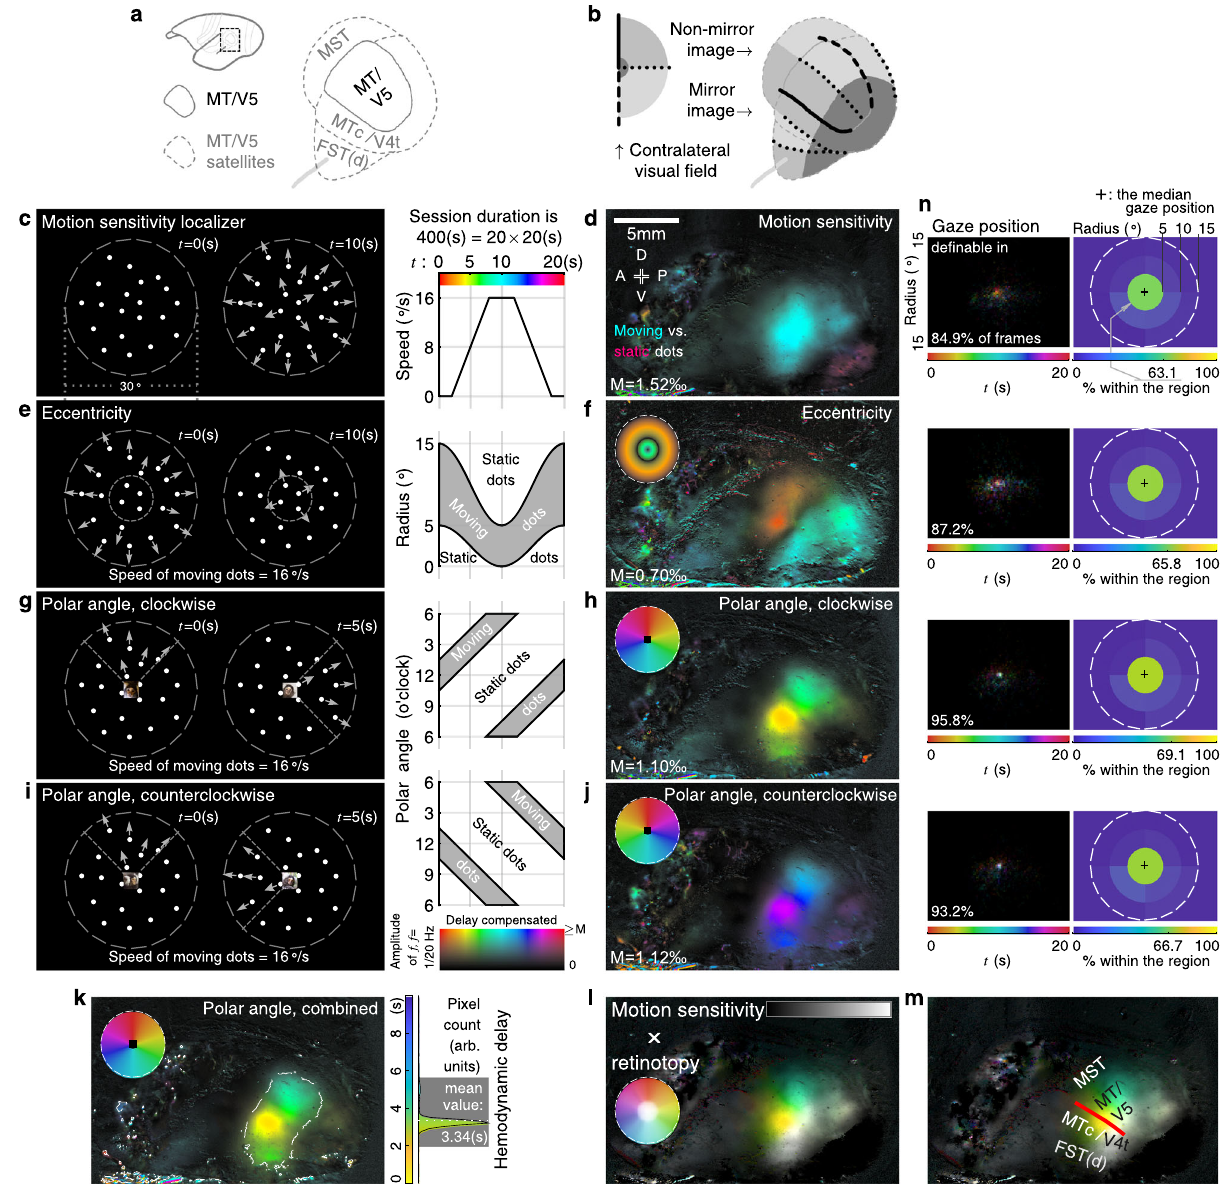
Fig. 5 Through-skull retinotopy and motion-sensitivity mapping in the MT/V5 complex. a A sketch of marmoset MT/V5 complex 10,33 . MST: medial superior temporal area, MTc/V4t: MT crescent/transitional V4, FST(d): fundal area of the STS (dorsal). b The retinotopic organization of marmoset MT/ V5 complex, as in Rosa and Elston 1998 33 . c , e , g , i Stimuli for mapping motion sensitivity ( c ), retinotopic eccentricity ( e ), and polar angle tuning with clockwise ( g ) and counterclockwise ( i ) sequences. d , f , h , j Resulted maps in subject M126D (the same subject as in Figs. 2, 3f, 6, 7. See also Supplementary Fig. 6 for all tested subjects). A: anterior; P: posterior; D: dorsal; V: ventral. k Combined polar angle map with a hemodynamic delay histogram. The top 10% of most responsive pixels are outlined (dashed curves) and counted in the histogram. Rectangular gray shade: the acceptable delay range. l The summary map by combining the retinotopic and motion-sensitivity maps. These maps are encoded into separate channels in the HSV color space. The polar angle tuning ( k ) is encoded in the hue (color) channel, whereas the eccentricity ( f ) is encoded in the saturation (chroma) channel. The color wheel incorporates these retinotopic features: a pixel sensitive to the center (< 5° radius) would appear in white, whereas a pixel sensitive to the periphery would appear in a vivid color according to its polar angle tuning. The motion sensitivity ( d ) is encoded in the value (intensity) channel. The more motion sensitivity a pixel exhibits, the brighter it appears. m A putative assignment of area labels. The red line: the polar angle tuning reversal. n Eye- tracking results of these sessions. The calibrated and de fi nable gaze position of each frame is color-coded for its cycle timestamp and overlaid in a 2D visual fi eld histogram (left panels). A white spot in the histogram implies the position was not preferred by any speci fi c time point in the cycle. For each session, the median gaze position was estimated 1.1°, 0.9°, 0.8°, and 0.9° away from the center. Response maps ( d , f , h , j , k ) are shown with tuning phase (color) and response amplitude (intensity) separately encoded, according to the 2D colormap by the left side of ( j ). The colormap is also transformed into wheel-shaped visual fi eld color codes in ( f , h , j , k ). The upper display limit of response amplitude “ M ” is listed at the bottom left in ( d , f , h , j